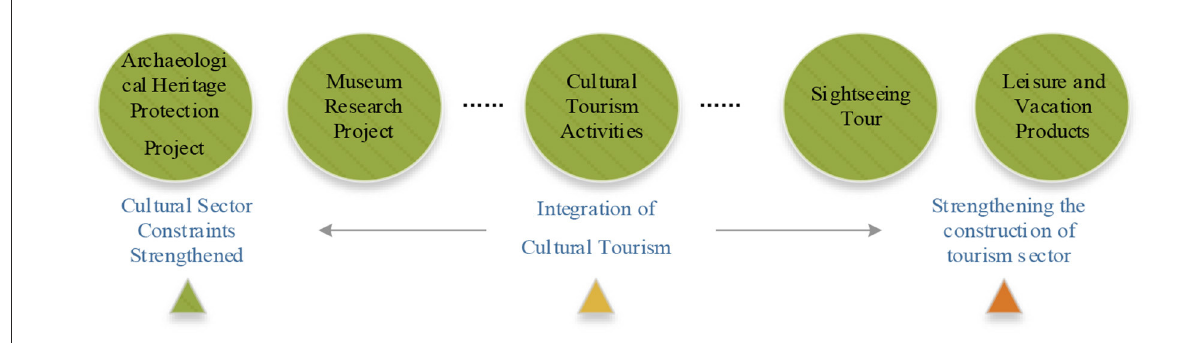
FIGURE5 Schematic diagram of the product lineage of the integrated development of the two sectors of cultural